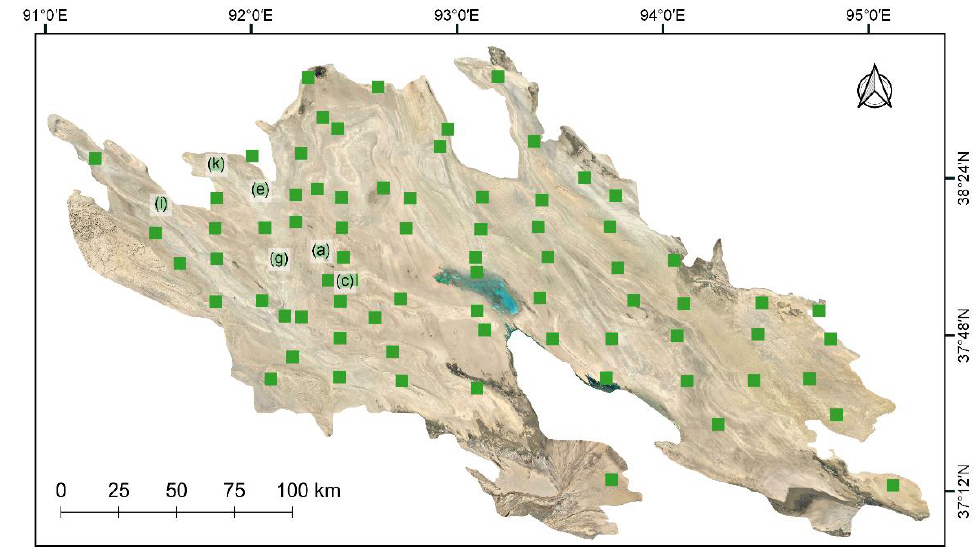
Figure 2. The 80 case study sites (marked by green squares) selected in the yardang field of the marked with letters correspond to the enlarged image scenes in Figures Qaidam Basin. The squares marked with letters correspond to the enlarged image scenes in Fig- ures 5-8.